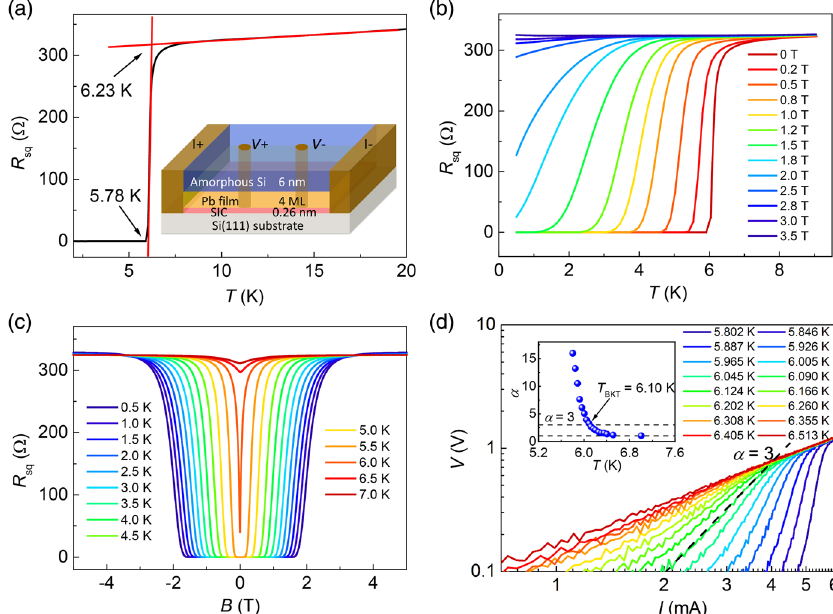
FIG. 2. Transport properties of 4-ML Pb film (sample 1). (a) Temperature dependence of sheet resistance R showing T onset c ¼ 6 . 23 K and T zero c ¼ 5 . 78 K. The inset is a schematic for standard four-electrode transport measurements. (b) R measured under various perpendicular magnetic fields up to 3.5 T. (c) The field dependence of R 0.5 to 7.0 K. (d) V ð I Þ characteristics at various temperatures from 5.802 to 6.513 K at B ¼ 0 T plotted on a double-logarithmic scale. The black line corresponds to V ∝ I 3 dependence. Inset: Power-law exponent α ( V ∝ I α ) as a function of temperature, showing T ¼ 6 . 10 BKT